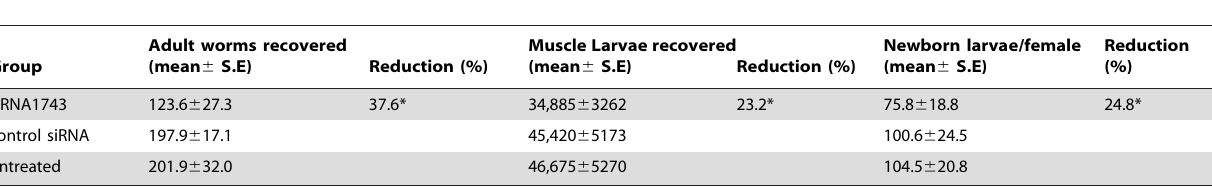
Table 2. Recovery of adult worms, muscle larvae and newborn larvae of T. spiralis from mice infected with larvae transfected with siRNA1743 by